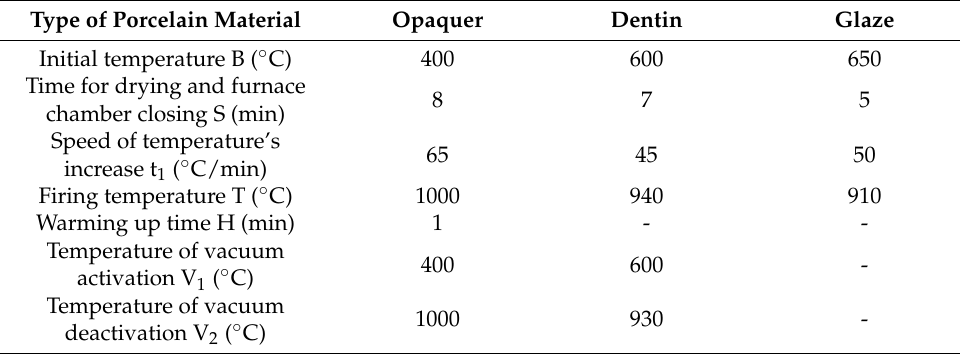
Table 3. Firing simulation parameters for